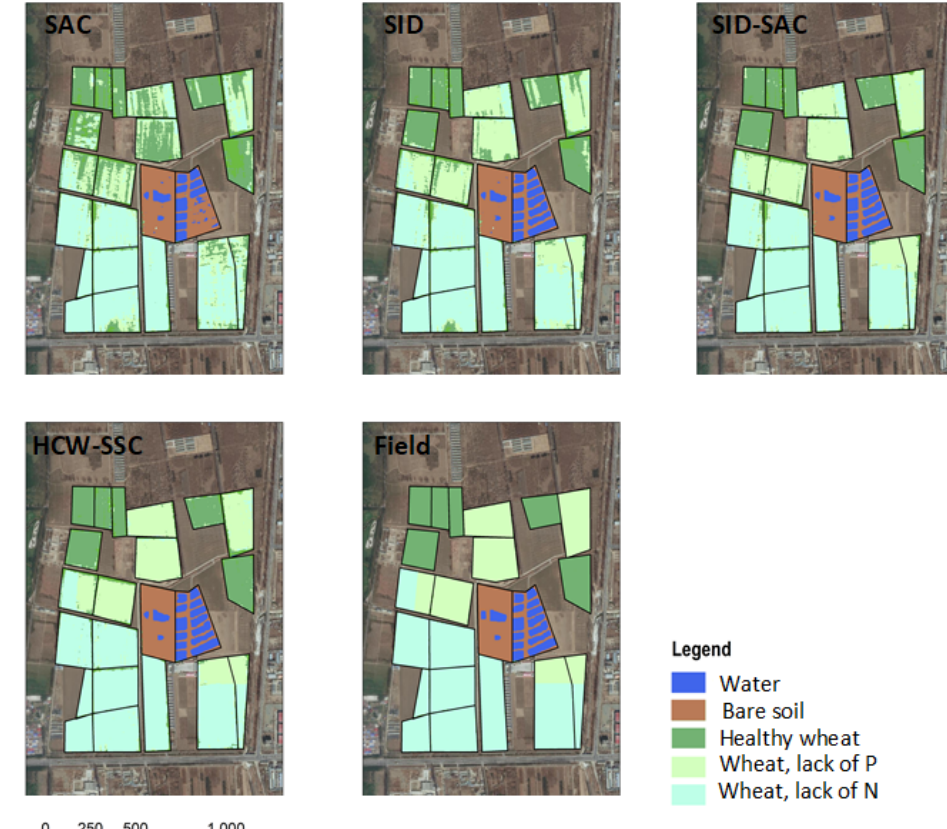
Figure 6. Classification maps of four different classification methods and the field measurement (spectral angle cosine (SAC), spectral information divergence (SID), spectral information divergence–spectral angle cosine (SID-SAC), and a new hybrid changing-weight classification method with a filter feature selection (HCW-SSC)).